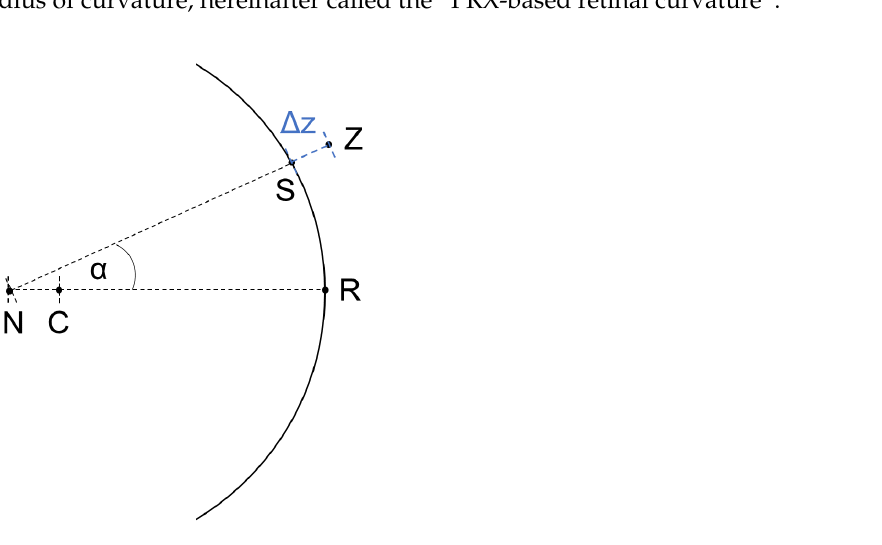
Figure 2. Process of retinal shape calculation from OCT imaging: scheme of an eye with the retinal curvature of the Arizona eye model [22], its circle center C, and ocular nodal point N (adjustable for the axial length). For each scan angle α , the peripheral refraction (PRX) shift ∆ z was added or subtracted for myopic or hyperopic defocus to the length NS , respectively. A circle was then fitted to all resulting points Z . The image displays the case of myopic defocus and a subsequent elongation of NS by ∆ z